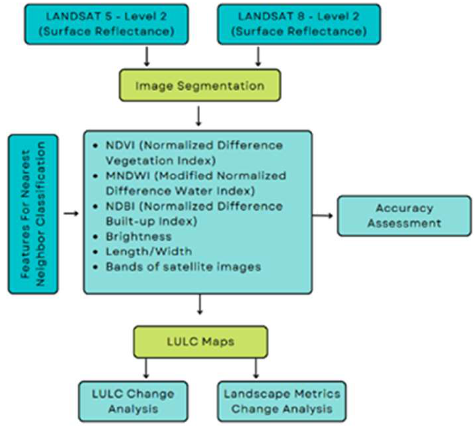
Figure 2. Flow chart of the study. Figure 2 . Flow chart of the study.